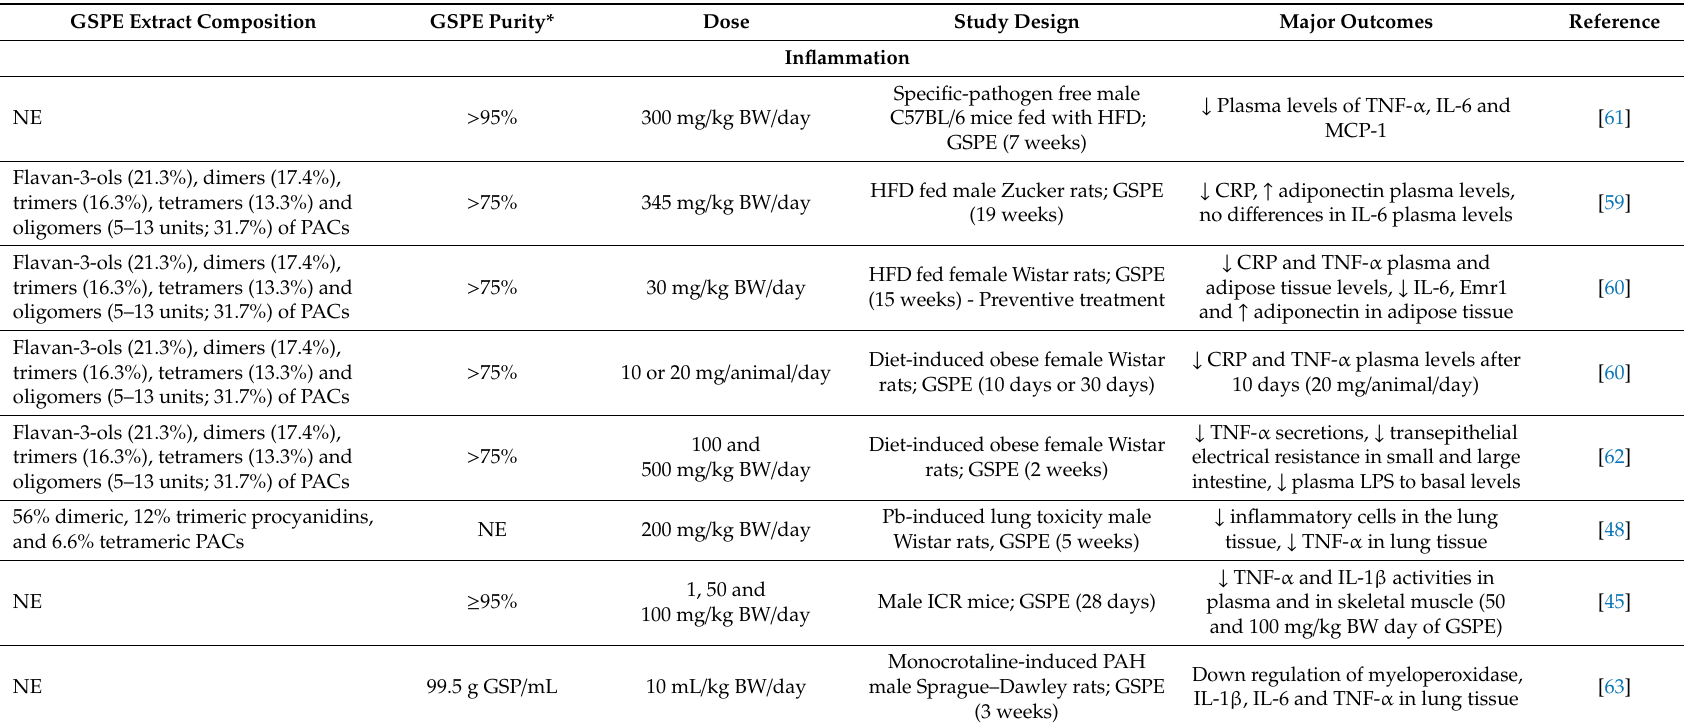
Table 2. E ff ect of proanthocyanidins from grape seeds on inflammation in animal